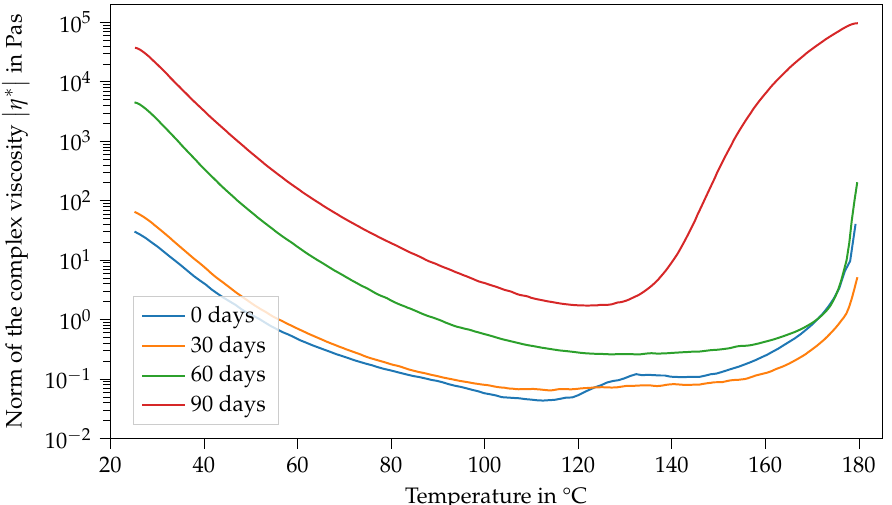
Figure 9. Norm of the complex viscosity of Argopox-2.5 between 25°C and 180°C after storage periods of 0d, 30d, 60d and 90d at T = 22°C.